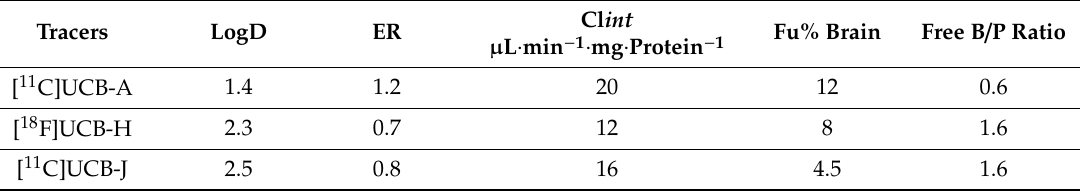
Table 2. Main PK / PD characteristics of the first-generation of SV2A radiotracers derived from